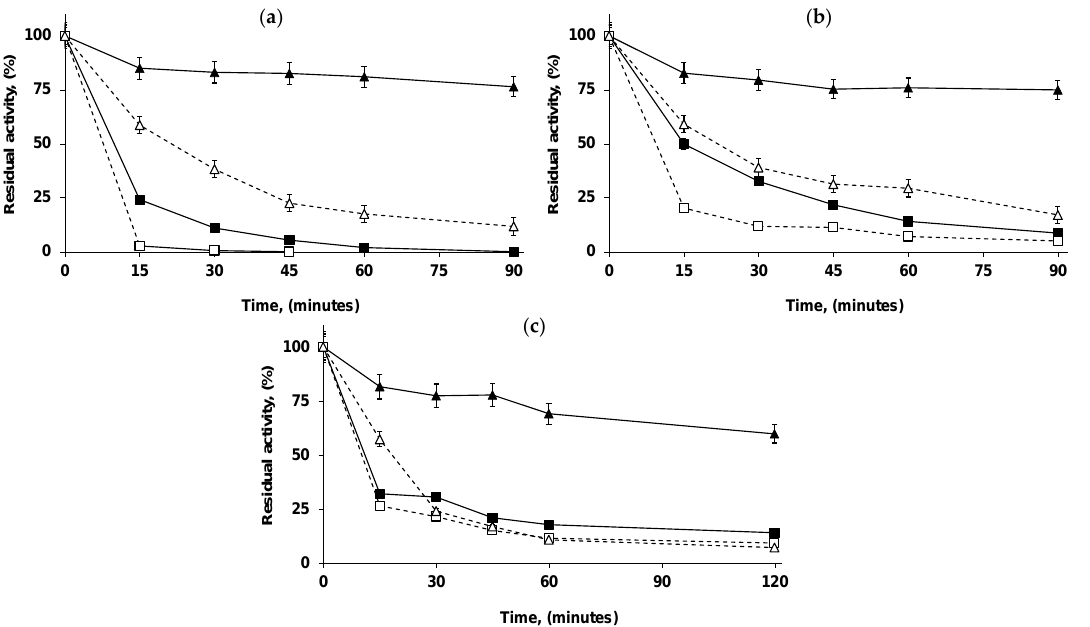
Figure 4. Inactivation courses of different enzyme preparations. The biocatalysts were incubated under different conditions ( a ) in 50 mM of sodium acetate at pH 5.0 and 72 °C, ( b ) in 50 mM of Tris at pH 7.0 and 72 °C, or ( c ) in 50 mM sodium carbonate at pH 9.0 and 70 °C. Other specifications are described in the Methods section. Continuous lines and filled squares: TLL-octyl; continuous lines and filled triangles: ET-octyl; dotted lines and empty squares: free TLL; dotted lines and empty triangles: free ET.